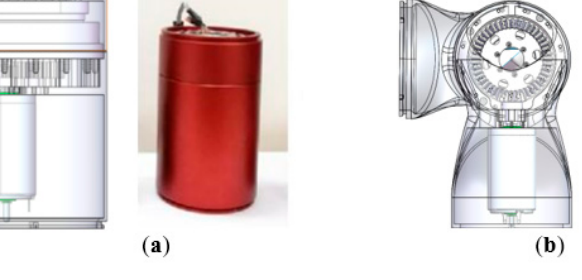
Figure 3. Typical module types. ( a ) 1-type, ( b ) 7-type, ( c ) 6-type (the gripper).